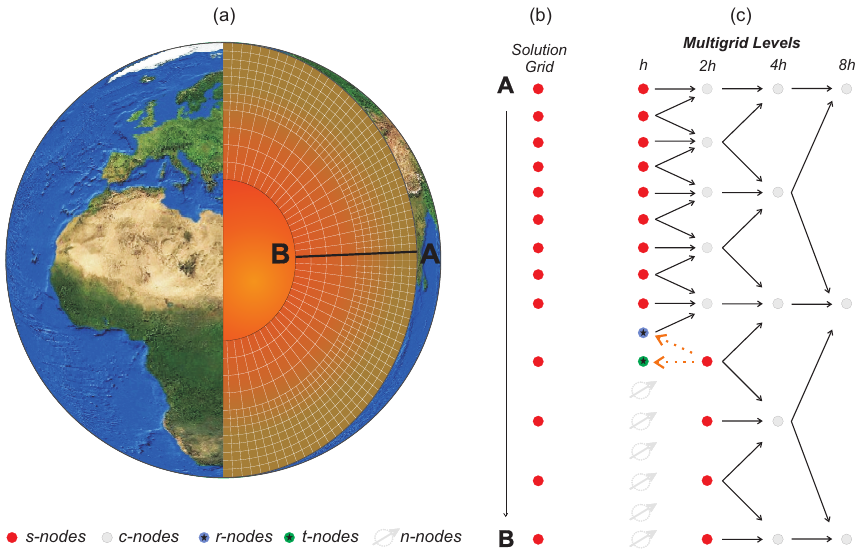
Fig. 2. (a) The reference grid configuration implemented in this study. The final solution is derived from distinctive local grids, with high resolution in the upper half of the spherical shell and coarser resolution in the lower half. (b) A radial section, drawn along A–B, illustrating the final non-uniform solution grid. (c) The multigrid solution process, illustrated for a four level cycle (grids h − 8 h ). Grid level h is a local fine-grid that spans the upper half of the mantle. Nodes shaded in red are those intrinsic to the final solution ( s nodes). r and t nodes are utilized during fine-grid calculations. They ensure solution accuracy on the fine-grid and solution continuity during inter-grid projection. n nodes would occur in the regular multigrid formulation, but do not exist in the modified formulation. Grid level 2 h is a global grid, covering the whole mantle. As with grid level h , nodes shaded in red are part of the final solution ( s nodes). Conversely, nodes shaded in grey ( c nodes) are only utilized during the multigrid process; they do not explicitly contribute to the final solution. Grids 4 h and 8 h are further global grids, which are involved in the multigrid solver but do not explicitly contribute to the final solution. Black arrows denote inter-grid projection. These are reversed for coarse-to-fine grid interpolation, whilst dashed orange arrows are also applicable. Note, grid resolution is decimated for illustrative purposes.